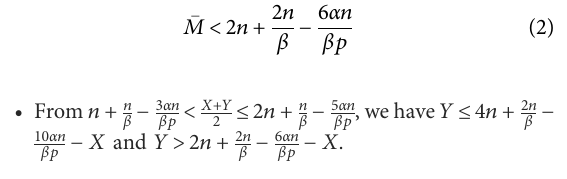
As shown in Figure 1, the average monthly electricity consumption of residents during peak and off-peak seasons and the upper limit of the monthly electricity consumption of residents are divided into regions to determine users who choose Package 3. From the electricity consumption data of a certain area used in the calculation example of this study, the upper limit of monthly electricity consumption is assumed in Eq. 2. We have veri fi ed that when the critical point is exceeded, most users will choose Package 3. For the rationality of package setting, the upper limit is assumed to be less than this critical point.